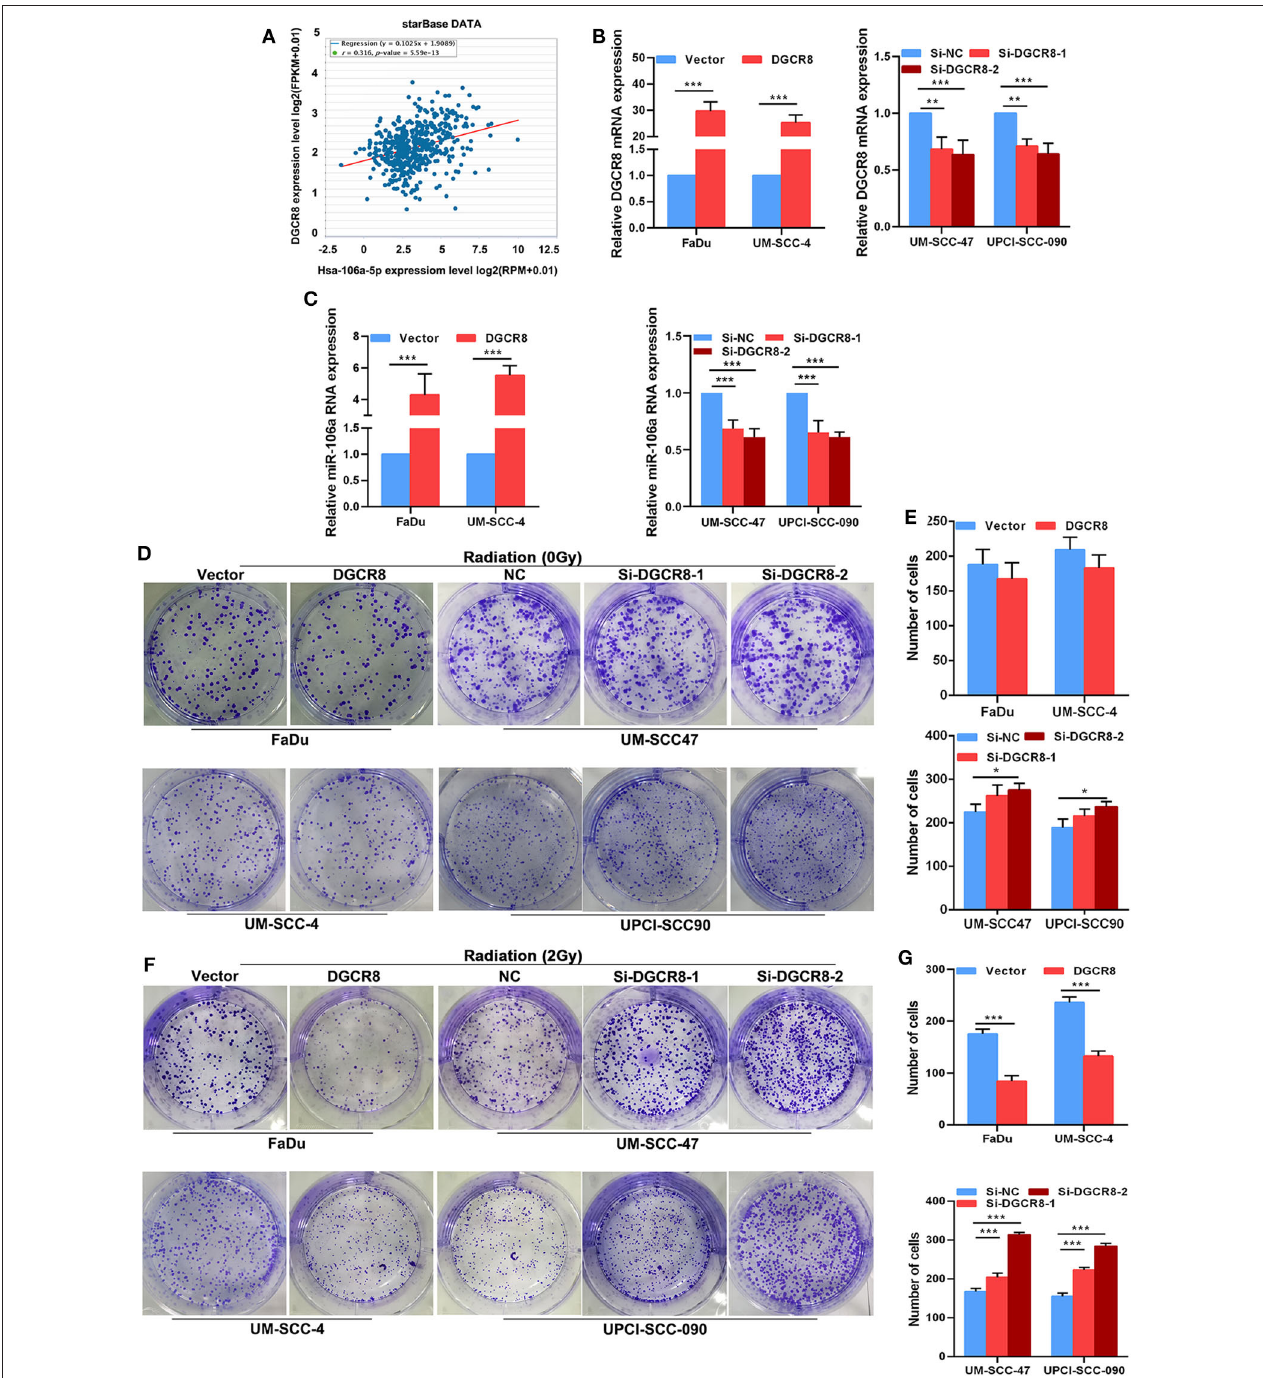
FIGURE 2 | DGCR8 promotes hsa-miR-106a transcription and enhances radiation sensitivity. (A) Correlation between DGCR8 and hsa-miR-106a based on TCGA-HNSC cohort. (B) The mRNA expression of DGCR8 in the human papillomavirus (HPV)-positive and HPV-negative cells. (C) Expression level of hsa-miR-106a was measured in HPV-negative cells with DGCR8 overexpression and HPV-positive cells with DGCR8 silencing. (D,E) The effect of DGCR8 on cell proliferation was detected by clonogenic survival upon DGCR8 overexpression in HPV-negative cells and DGCR8 silencing in HPV-positive cells. (F,G) The sensitivity of the cells to radiation was detected by clonogenic survival upon DGCR8 overexpression in HPV-negative cells and DGCR8 silencing in HPV-positive cells. * p < 0.05, ** p < 0.01, *** p < 0.001.